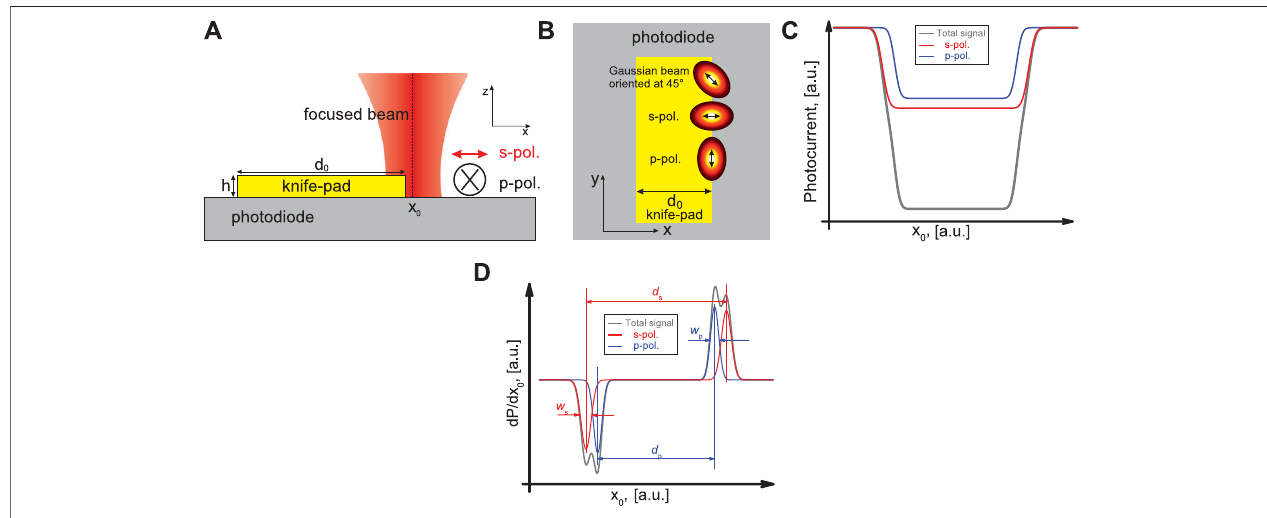
FIGURE1| Schematicdepictionoftheknife-edgemethod xz- plane (A) and xy -plane (B) .Thestateofpolarizationalwaysreferstotheorientationoftheelectric fi eld of the incoming beam relative to the knife-edge in the xy -plane. Typical beam pro fi ling data (photocurrent curves) (C) and their derivatives (beam-projections) (D) for a linearly polarized Gaussian beam (oriented at 45 ° (total signal) - gray, s -polarization - red, p -polarization - blue).